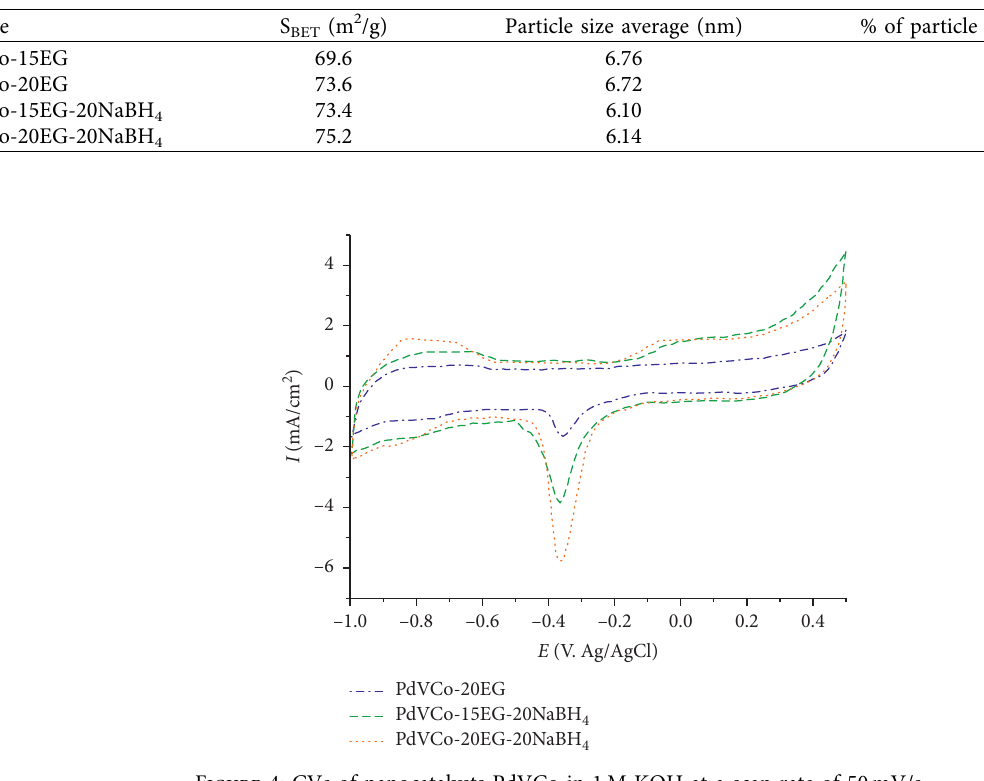
Figure 3: TEM images and particle size distribution nanocatalysts: (a) PdVCo-15EG; (b) PdVCo-20EG; (c) PdVCo-15EG-20NaBH (d) PdVCo-20EG-20NaBH 4 . Table 2: Specific area and particle size distribution of nano-PdVCo catalysts.